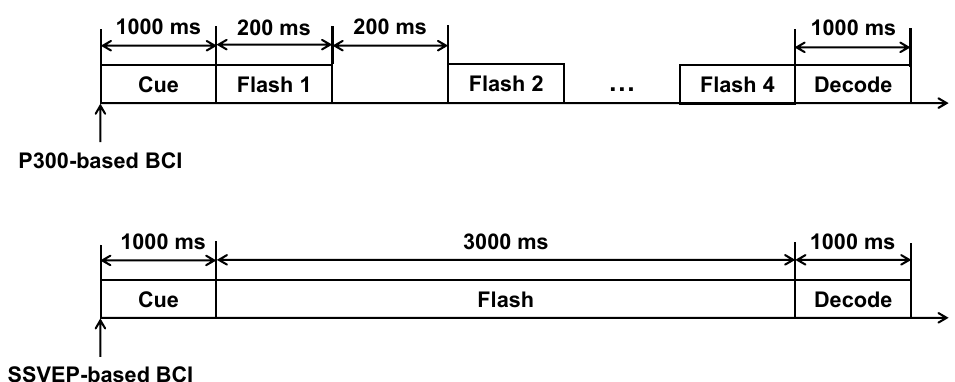
Figure 2. Illustration of the time courses.